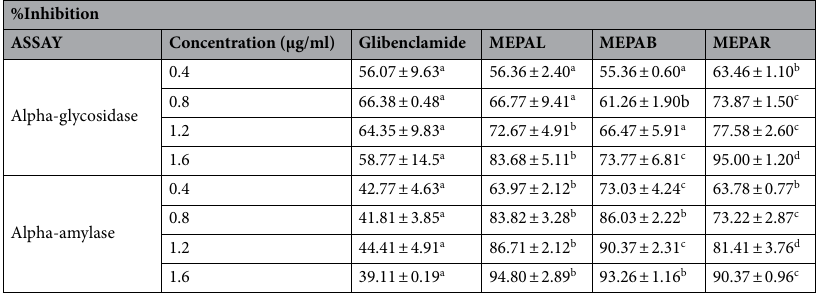
Table 4. Inhibition of alpha-glycosidase and alpha-amylase activity by extracts of P. americana. Values represent mean ± standard deviation of replicate readings. Values with different superscripts (a,b,c,d) along the same row are significantly different from one another (P < 0.05). Where MEPAL methanol extract of P. americana leave, MEPAR methanol extract of P. americana root, MEPAB methanol extract of P. americana stem bark.